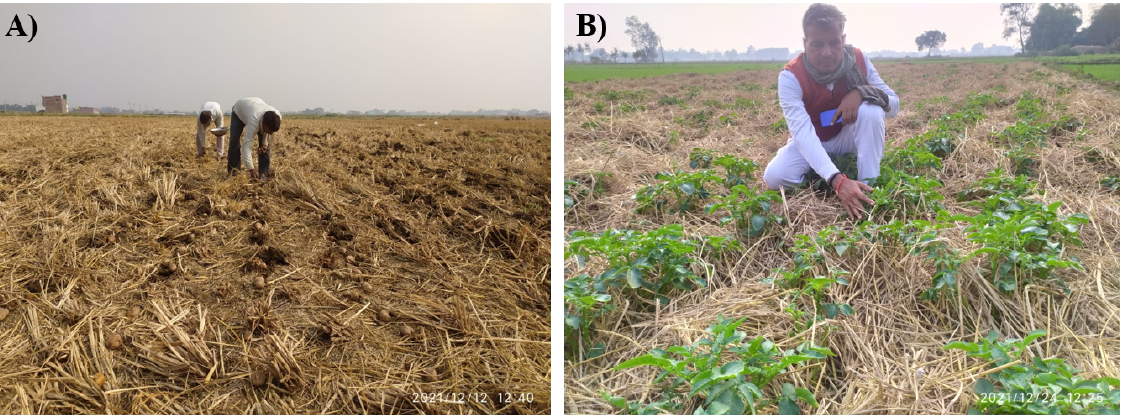
Figure 5. Potato cultivation under zero-tillage and rice-straw mulching (PZTM) on-farm demonstra- tion trials in Patna district, Bihar-India. After rice harvesting, potatoes seeds are placed in soil ( A ) and covered by manure and rice-straw mulch. Around 30 days after plating, emerged plants overpass the mulch ( B ). Photo credit: Suresh K.